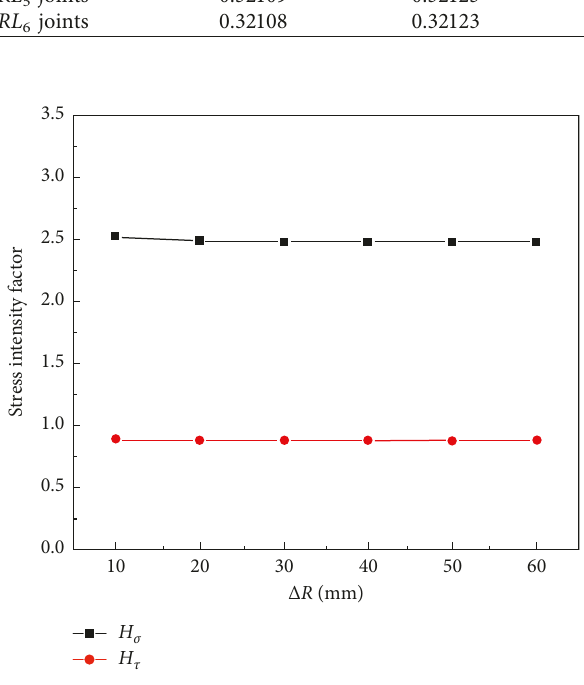
Figure 8: Stress intensity factor-